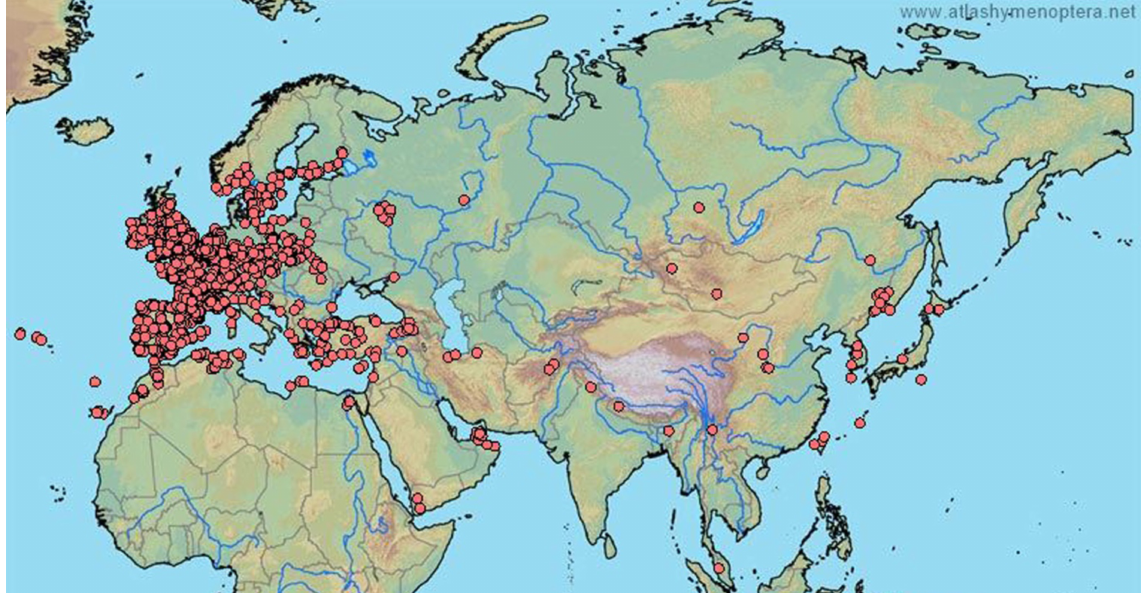
Fig. 1. Distribution of Lasioglossum villosulum (Kirby, 1802) throughout the Palaearctic and Oriental